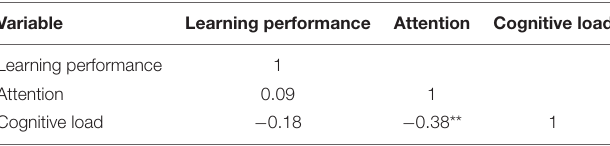
TABLE 5 | Pearson correlation analysis between cognitive load, attention, and learning performance.